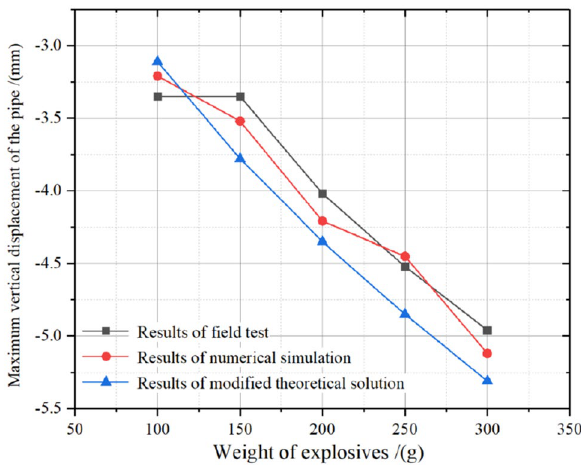
Figure 8. Comparison of results of the modified theoretical solution and field tests and numerical